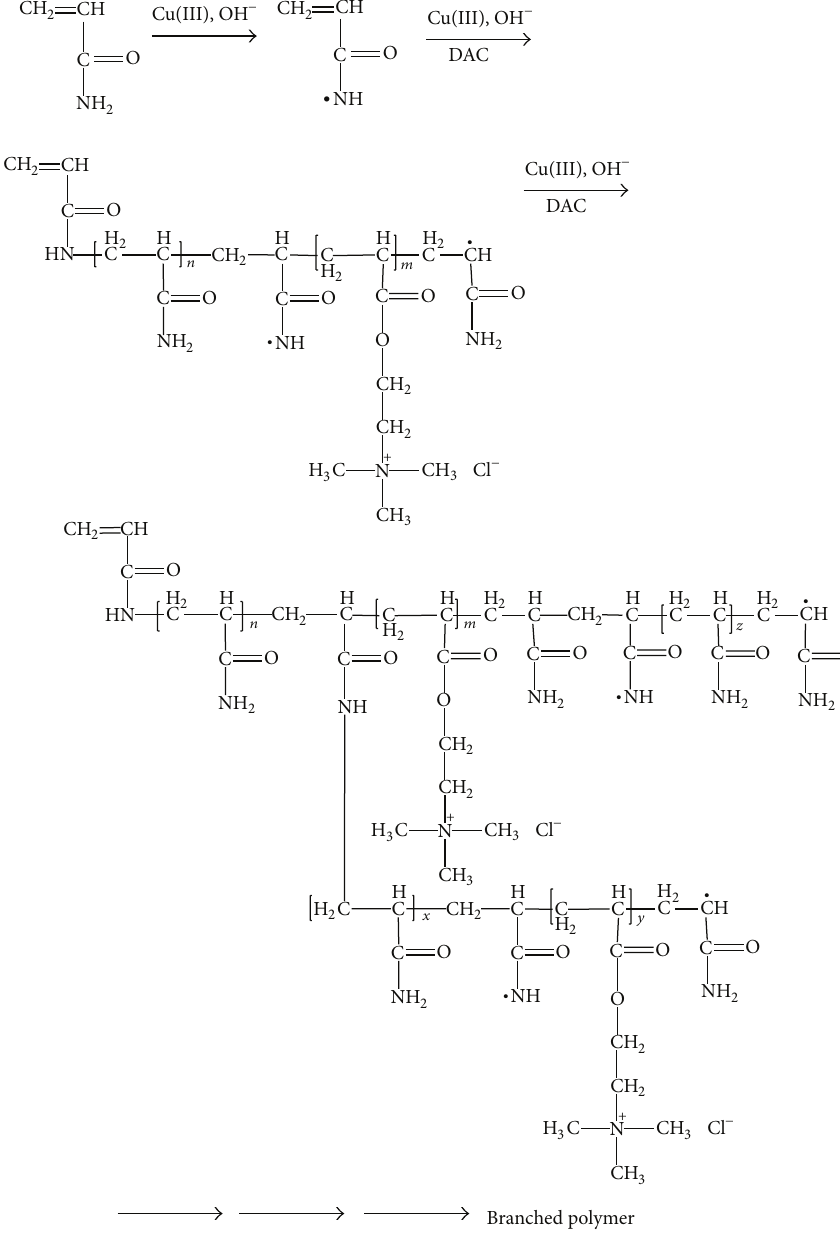
Figure 2: Synthesis reaction of branched cationic